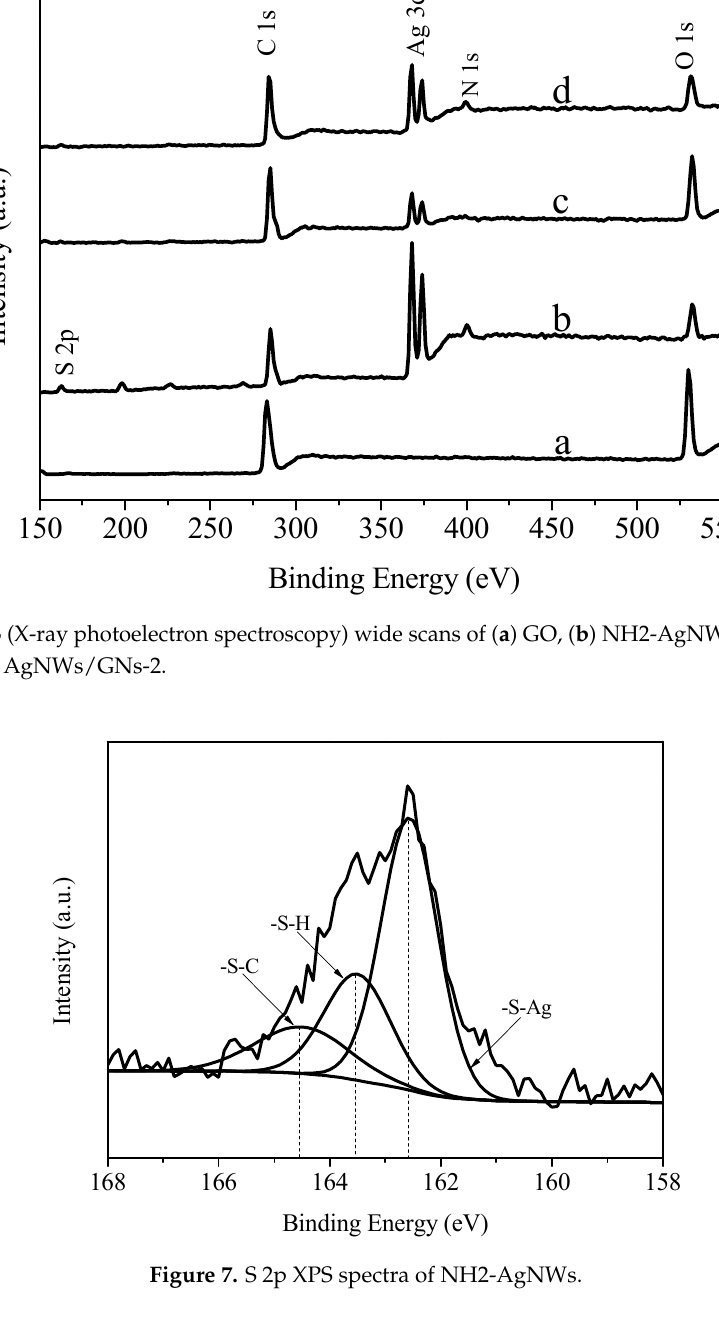
Figure 5. Raman spectra of the samples: ( a ) GO; ( b ) AgNWs/GO-2 and ( c ) AgNWs/GNs-2.